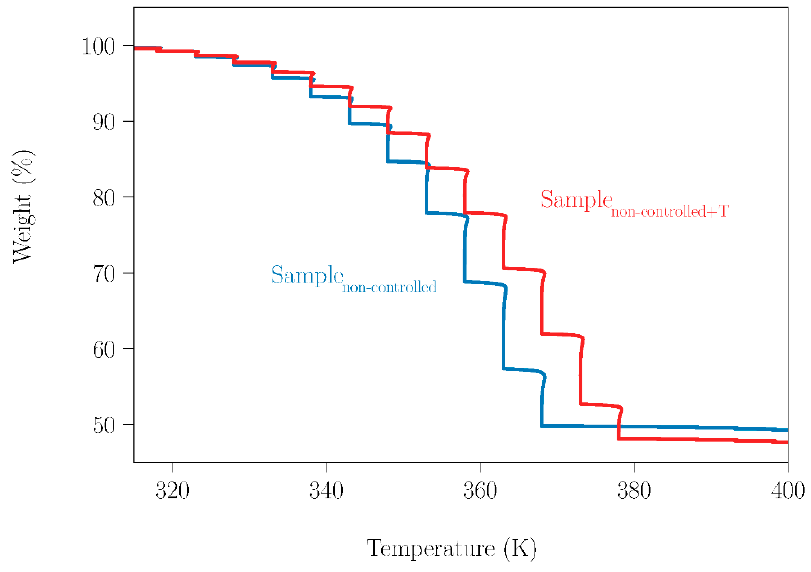
Figure 9. TGA measurement of S Lab and S Lab+T samples, from 310 K up to 400 K. Table 4. Thermoanalytic data for S Lab and S Lab+T samples.